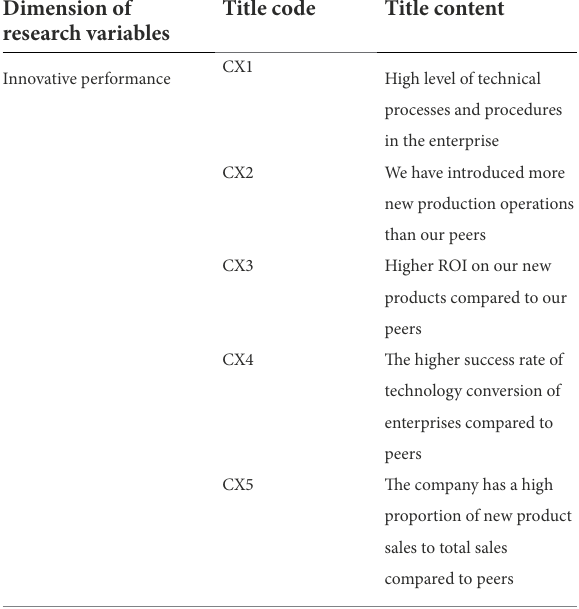
TABLE 3 Innovation performance